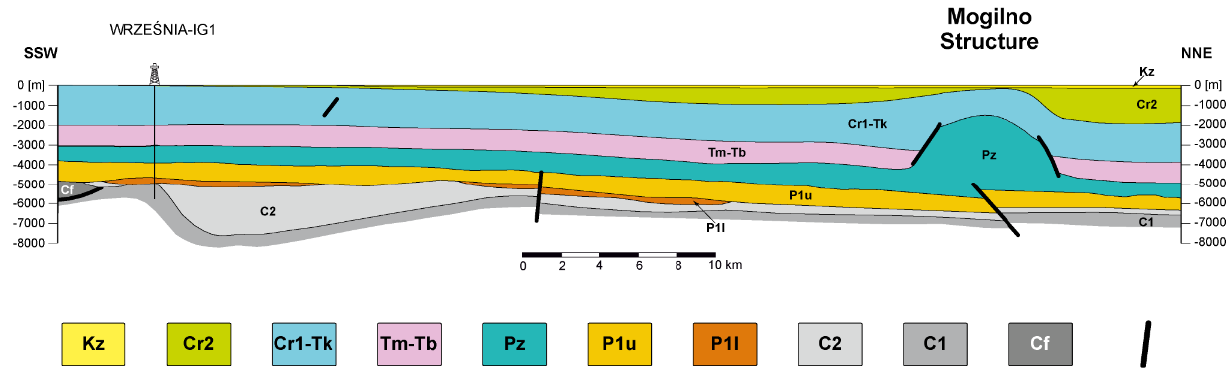
Figure 2. Geological cross ‐ section through the study area (Kz—Cenozoic, Cr2—Upper Cretaceous, Cr1 ‐ Tk—Lower Cretaceous Upper Triassic (Keuper), Pz—Zechstein, P1u—Upper Rotliegend, P1l—Lower Rotliegend, C2—Upper Carboniferous of the Hercynian Foredeep, C1—Lower Carboniferous of the Hercynian Foredeep, Cf—undivided folded Carboniferous of the Hercynian Orogenic Belt, bold line expresses the major faults).